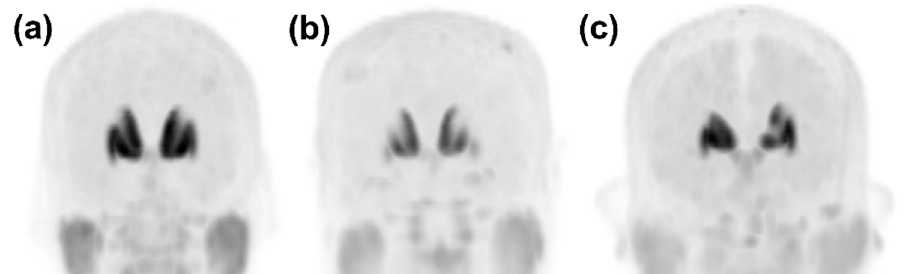
Figure 2. Representative anteroposterior maximum-intensity projection image patterns from [ 18 F]FP-CIT PET. ( a ) In the case that there was no focal defect or a decrease in dopamine transporter (DAT) binding of the striata, the pattern was classified as overall normal. ( b ) A PD pattern was defined as the typical DAT binding loss in the dorsal posterior putamen with relative sparing of a DAT binding loss in the ventral putamen. ( c ) A dVP pattern was defined as any focal DAT binding defect or decrease in the striatum that differed from the typical PD pattern. DAT, dopamine transporter; PD, idiopathic Parkinson’s disease; dVP, vascular parkinsonism with prominent defect or decreased dopamine transporter binding mimicking PD.